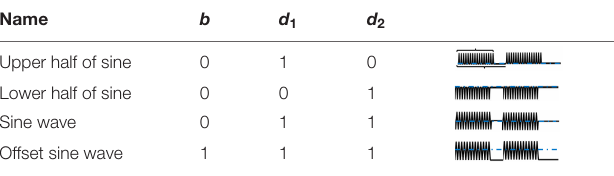
TABLE 2 | Relationship between the parameters and the ultrasonic shape.